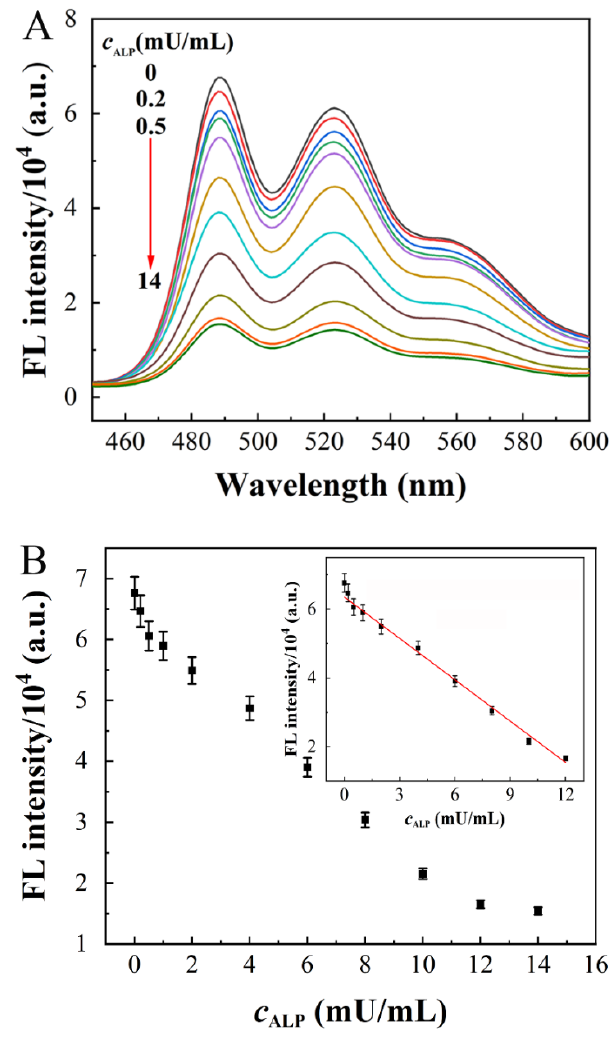
Figure 8. Fluorescent spectra ( A ) and linear correlation ( B ) of Ag-TPA CPNs in the presence of various concentrations of ALP. Note: c (ALP, mU/mL): 0, 0.2, 0.5, 1, 2, 4, 6, 8, 10, 12, 14; c (AA2P): 0.25 mM; Ag-TPA CPN solution: 50 μ L; λ ex : 320 nm; λ em : 490 nm. All error bars represent the standard deviation of three measurements. Table 1. A comparison of the different methods used for the detection of ALP activity .